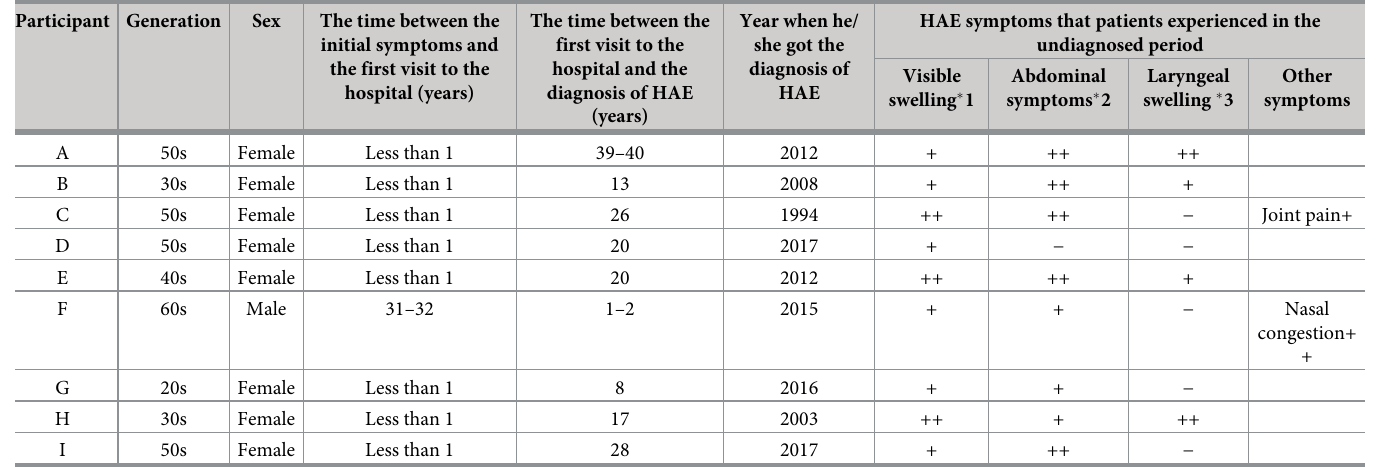
Table 1. Participant